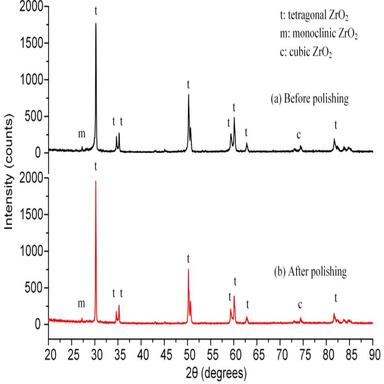
X-ray diffraction pattern of samples surfaces before and after polishing.